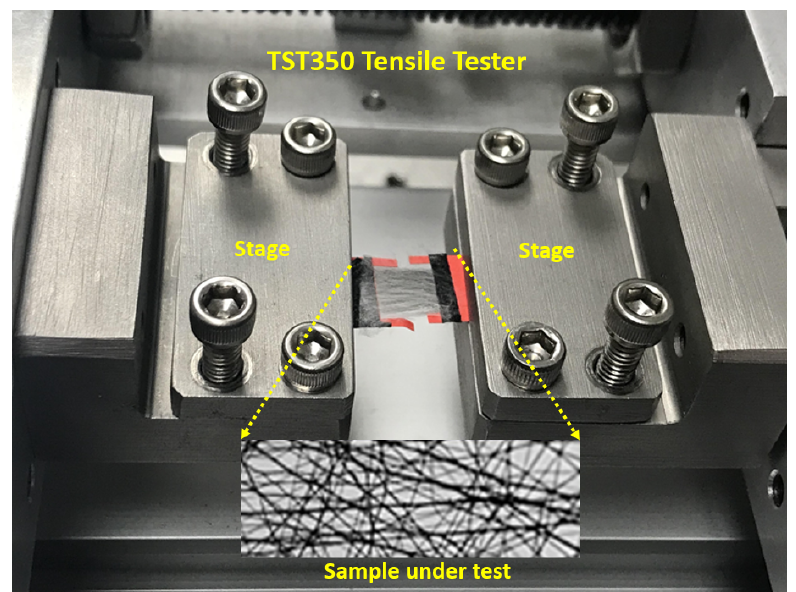
Figure 3. The uniaxial tensile tester experimental setup, with a sample under